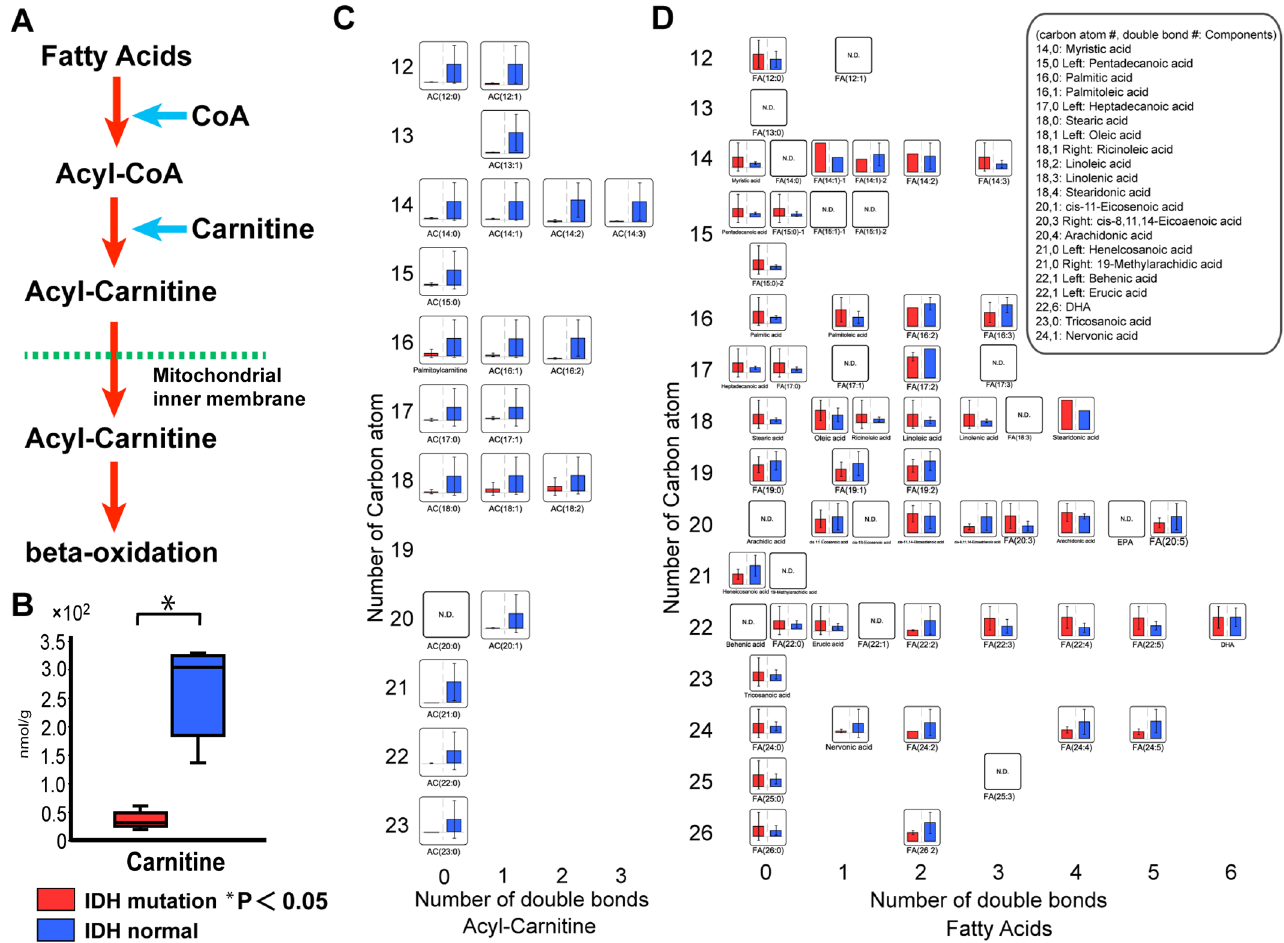
Figure 4. Analysis of carnitine and lipid metabolism in IDH mutation gliomas. ( A ) Schematic of the β -oxidation pathway: the lipid metabolism pathway. ( B ) Carnitine was reduced in the IDH mutant glioma group (red bars). The vertical scale shows the absolute quantification (nmol/g). ( C ) Acyl-carnitine was reduced in the IDH mutant glioma group (red bars). ( D ) Fatty acids were not obviously elevated in the IDH mutant glioma group (red bars). In graphs C and D , the vertical scales showed the number of carbon atoms. The horizontal axis scale shows the number of double bonds. The vertical scale shows the relative quantification based on the internal standard. Red bars, IDH1 R132H glioma; blue bars, normal IDH1 glioma; N.D., not detected; error bar, standard error of mean. * P <